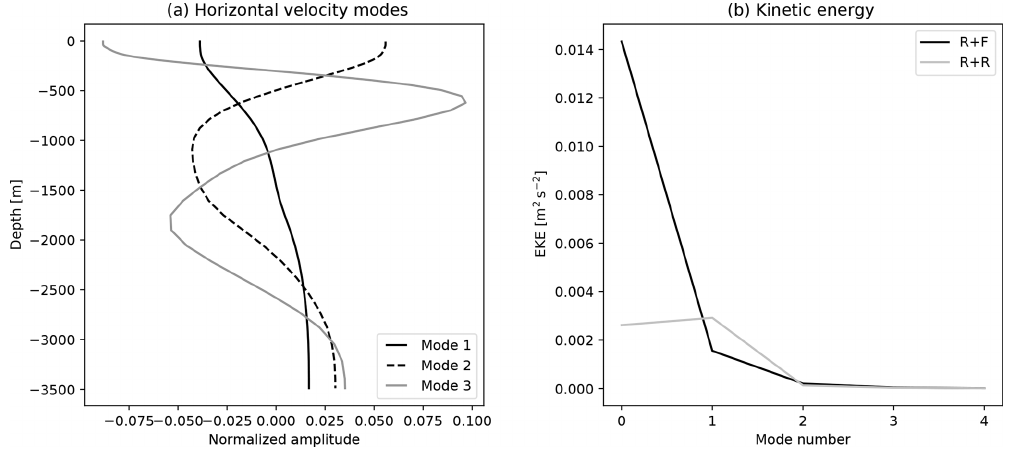
Figure 6. Normal mode analysis: (a) the first three baroclinic modes at position ( x = 0; y = 1000km) for the experiment flat and (b) kinetic energy (m 2 s − 2 ) contained in each mode, with mode 0 corresponding to the barotropic mode. The kinetic energy given in (b) results from a combination of, first, spatial averaging over 40 profiles taken at the central latitude ( y = 1000km) and regularly spaced in longitude all along the channel and, second, temporal averaging 120 snapshots obtained at monthly frequency over the last 10 years of simulations R + F and R +